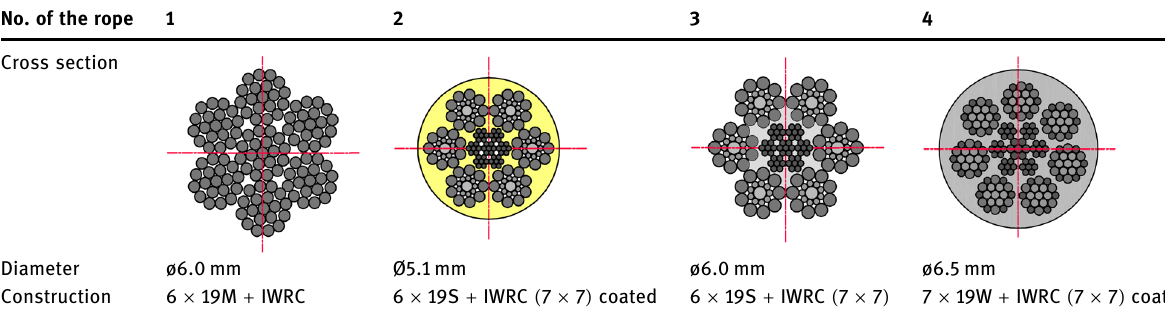
Table 1: Details of the ropes No. of the rope Cross